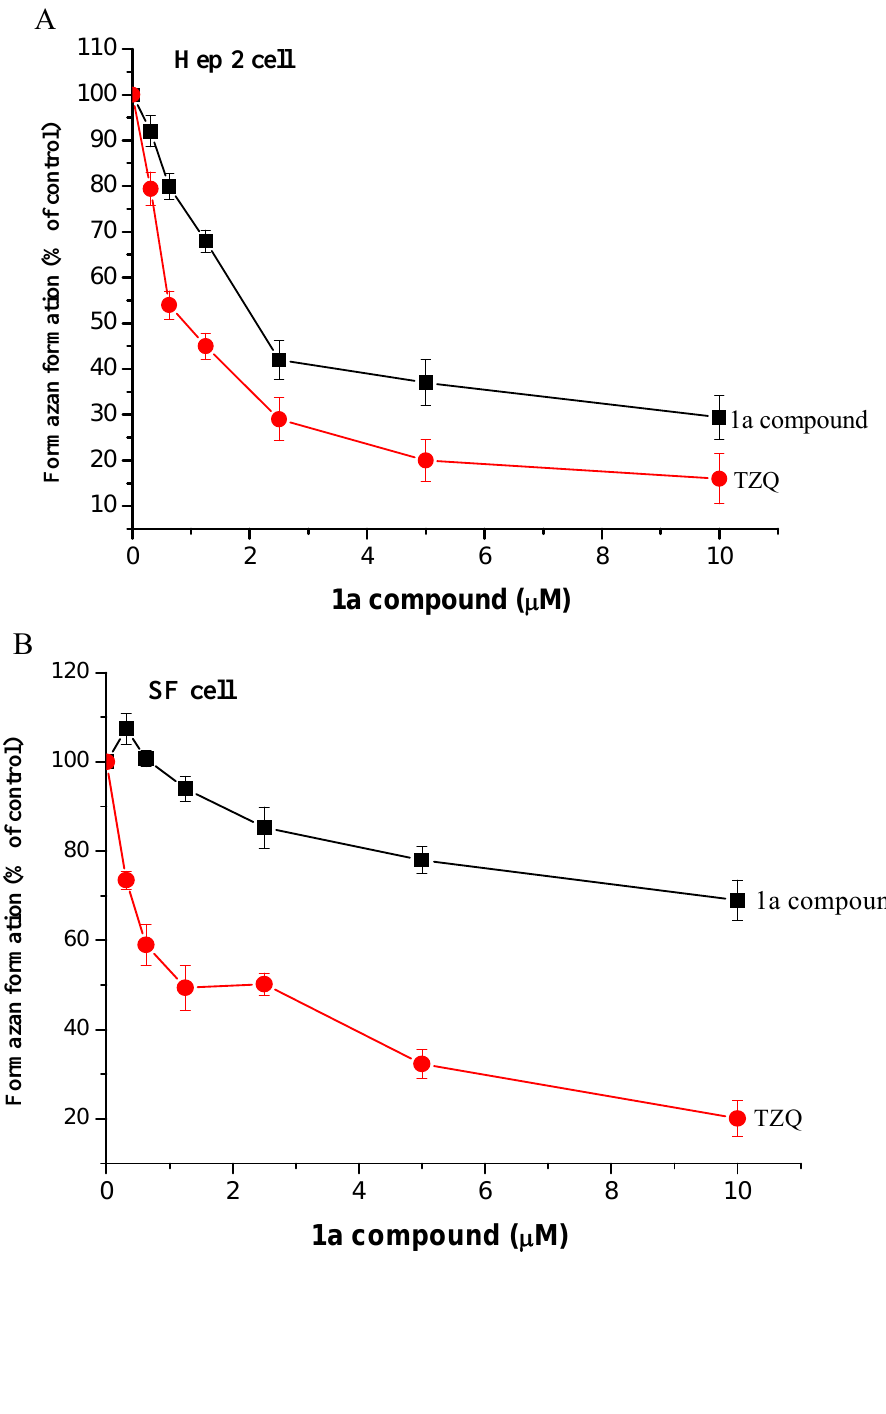
Figure 1. Compound 1a and TZQ inhibited the proliferation of cell lines Hep 2 (A) and SF (B) that were seeded for 18 hr before the addition of two compounds with various concentrations. The MTT assay was used to determine the cell viability after an additional 24 hr of culture. Data were from triplet wells and are representative of three separate